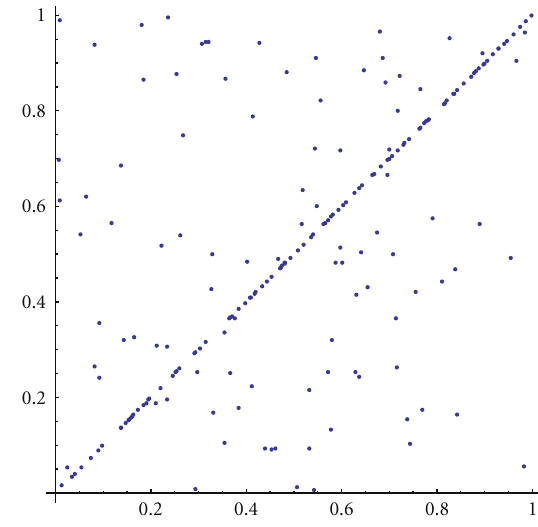
Figure 2: FLND architecture. Figure 3: Plot of the first two features of the second synthetic